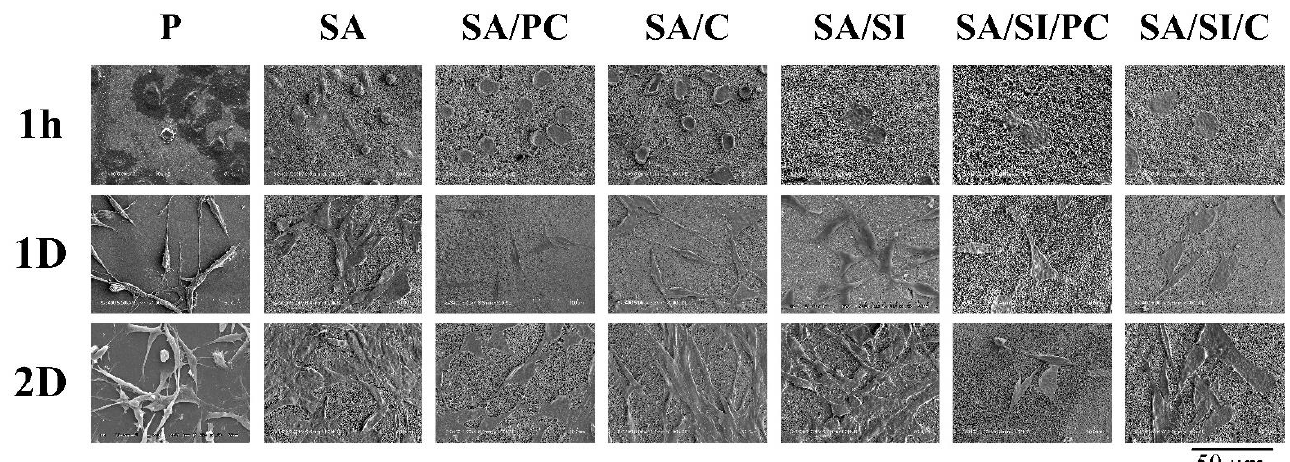
Figure 8. Microscopic images of progenitor D1 cell attachments on surface-modified PEEK for the culture periods of 1 h, 1 day, and 2 days.